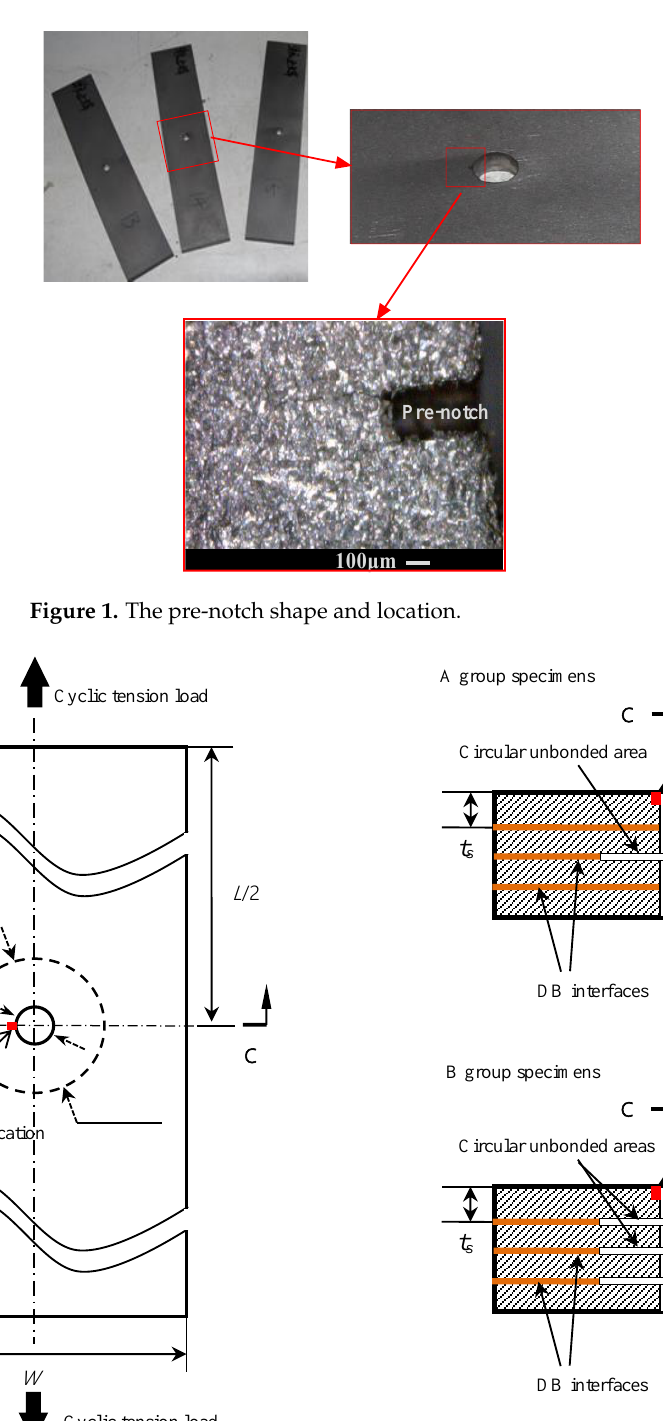
Figure 2. The layout of Groups A and B DBTALPUA specimens.